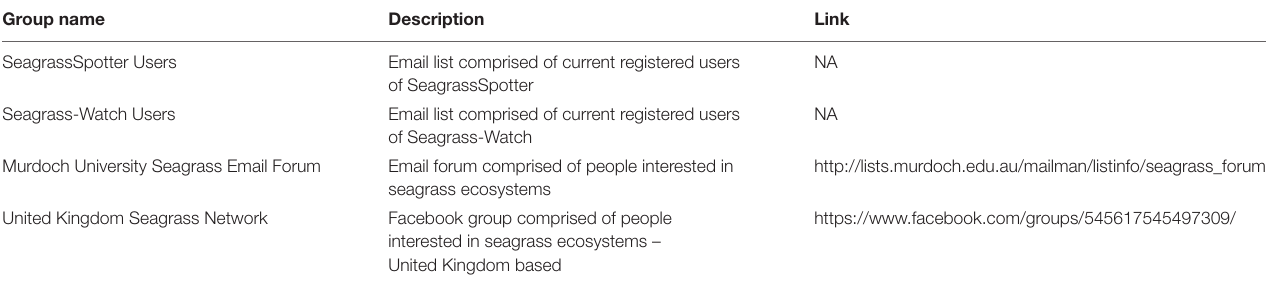
TABLE 1 | Description and links to survey dissemination